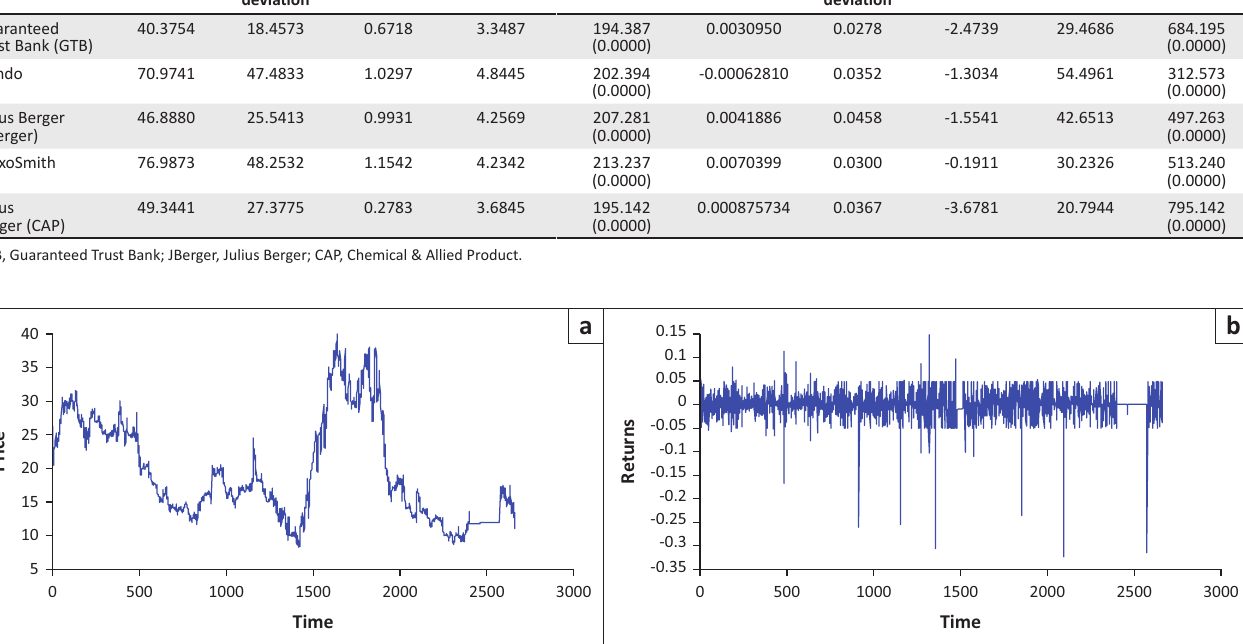
FIGURE 1: Guaranteed Trust Bank (GTB) (a) stock pricing over time, (b) returns over time.